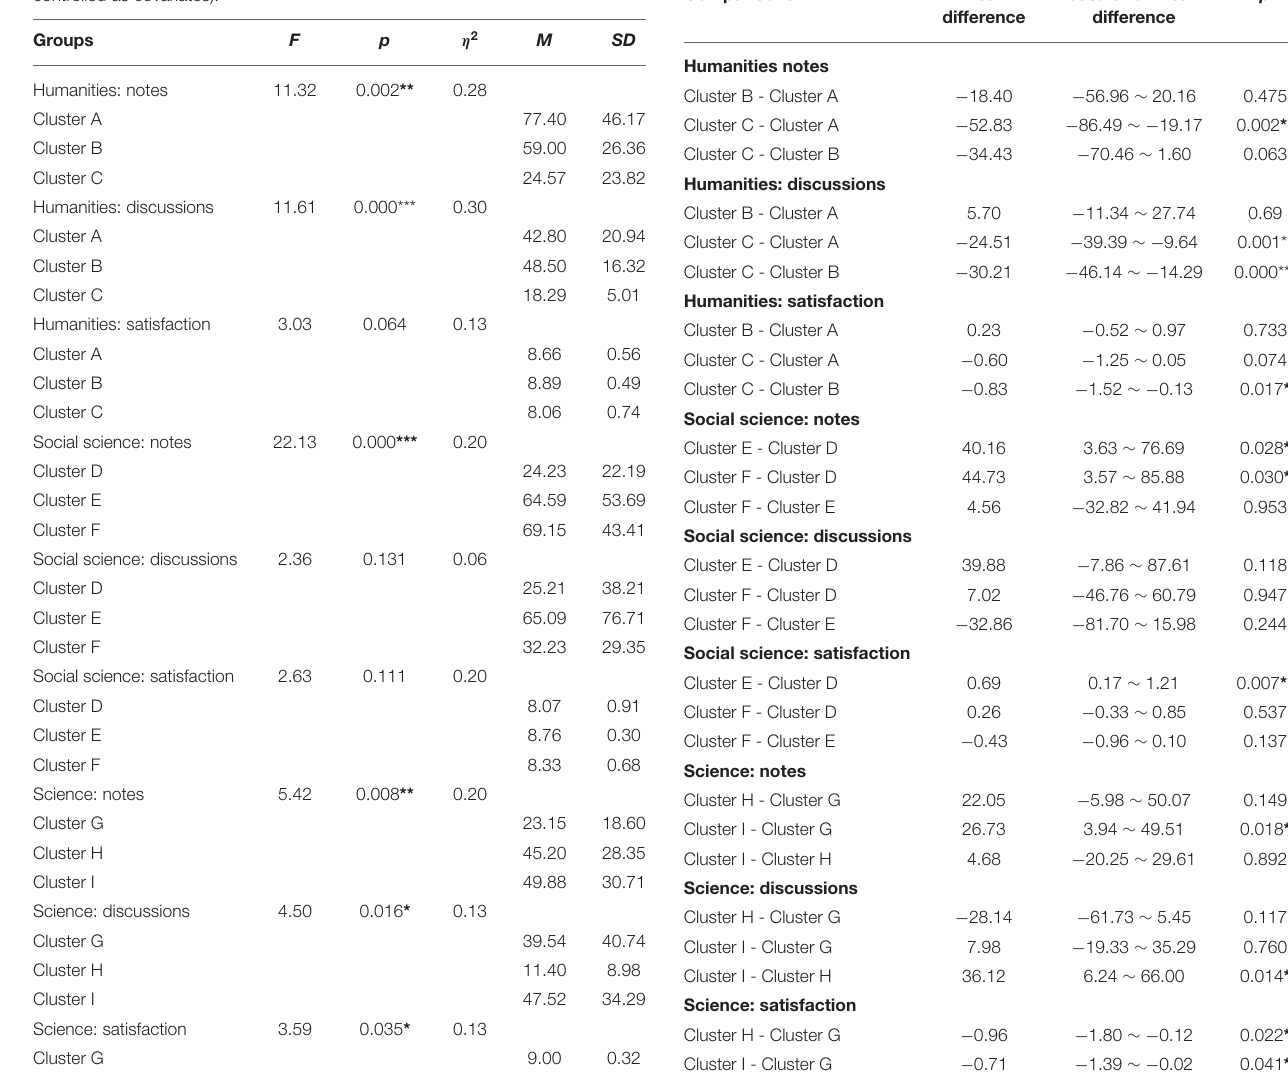
TABLE 1 | The differences of notes, discussions, and course satisfaction between different clusters within the three disciplines (the followers per course was controlled as covariates).